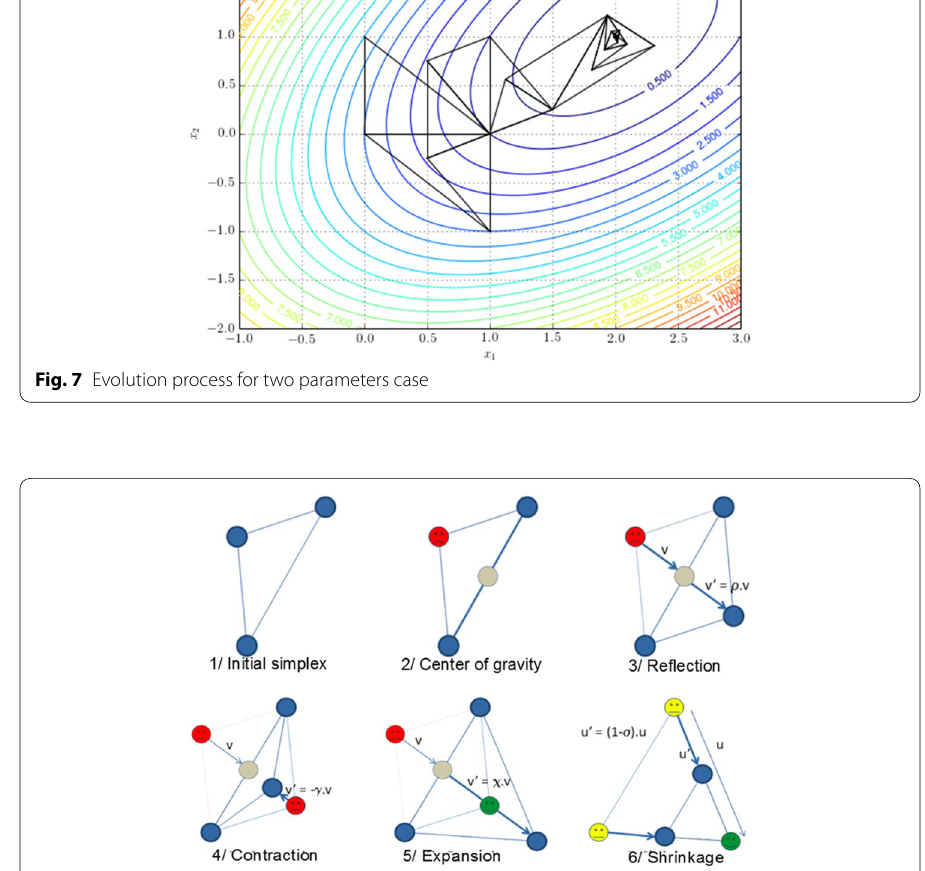
Fig. 8 Sequence of steps in one iteration of the Nelder–Mead